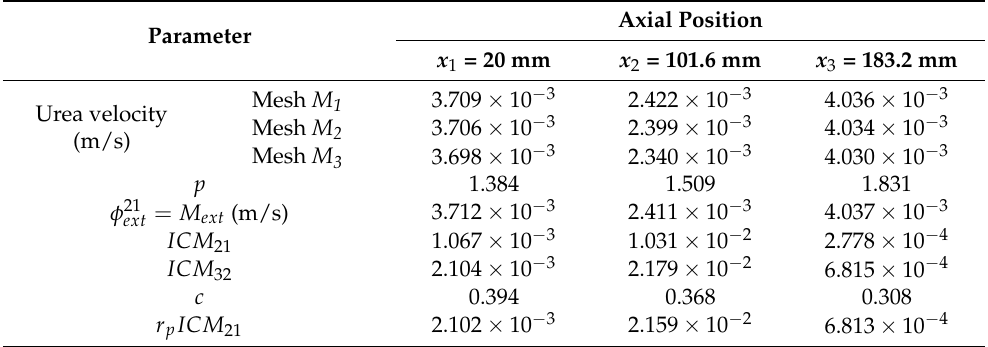
Table 6. Parameters obtained from the study of the Grid Convergence Index for urea velocity as response variable ( y = 0.159 m).